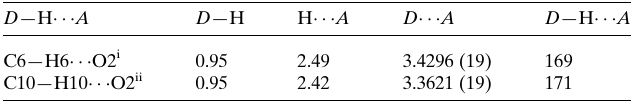
Table 1 Hydrogen-bond geometry (A˚ , (cid:2) ) for ( 1